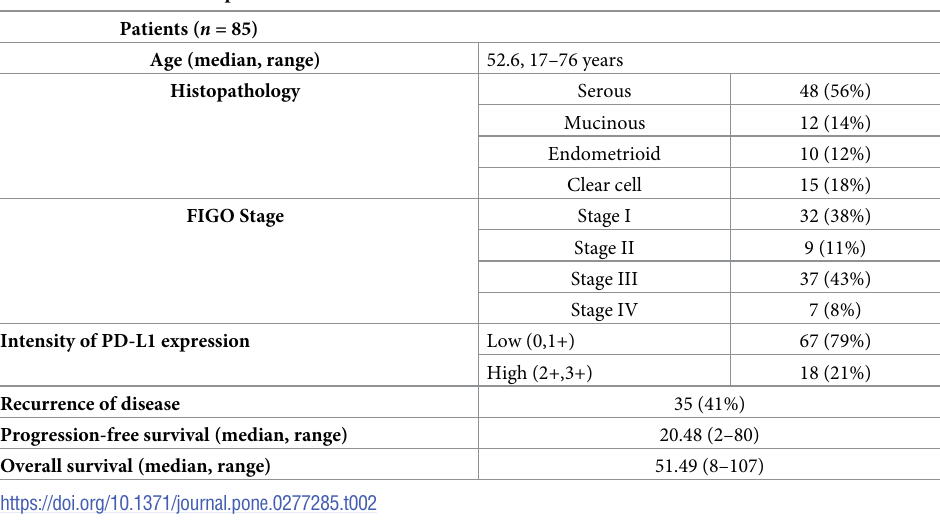
Table 2. Characteristics of